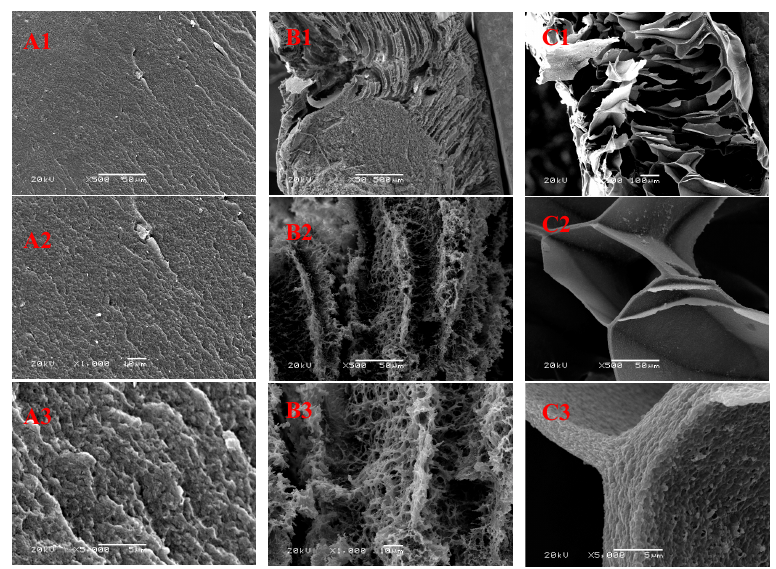
Figure 2. Scanning electron microscopy (SEM) images of the fracture surfaces of cellulose films; RC-A at 500× magnification ( A1 ), 1000× magnification ( A2 ) and 5000× magnification ( A3 ), respectively, RC-F at 50× magnification ( B1 ), 500× magnification ( B2 ) and 1000× magnification ( B3 ), respectively, RC-FF at 100× magnification ( C1 ), 500× magnification ( C2 ) and 5000× magnification ( C3 ), respectively.